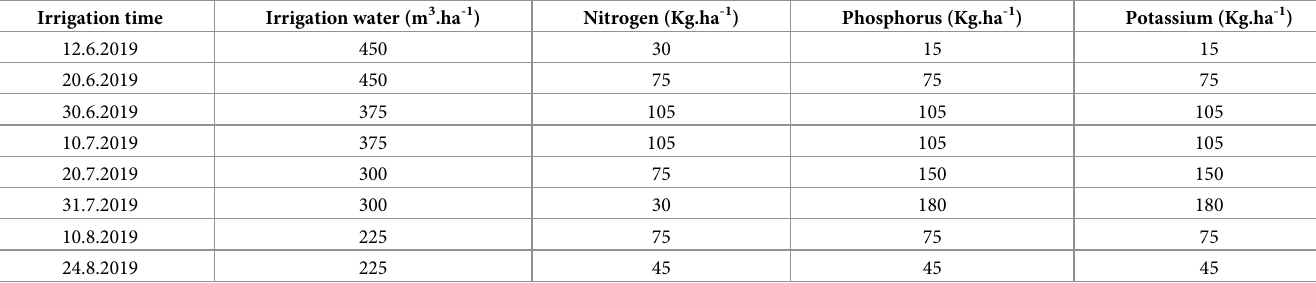
Table 2. The amount of nutrients (fertilizer) and water during the period of cotton irrigation in different mixing ratio 2019. Irrigation time